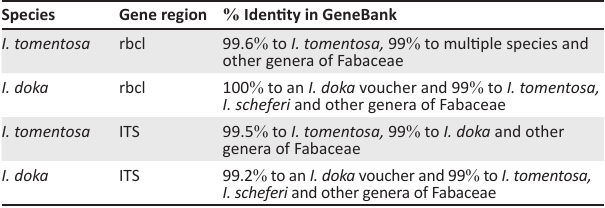
FIGURE 5: Agarose gel electrophoresis of internal transcribed spacer gene of Isoberlinia doka and Isoberlinia tomentosa.